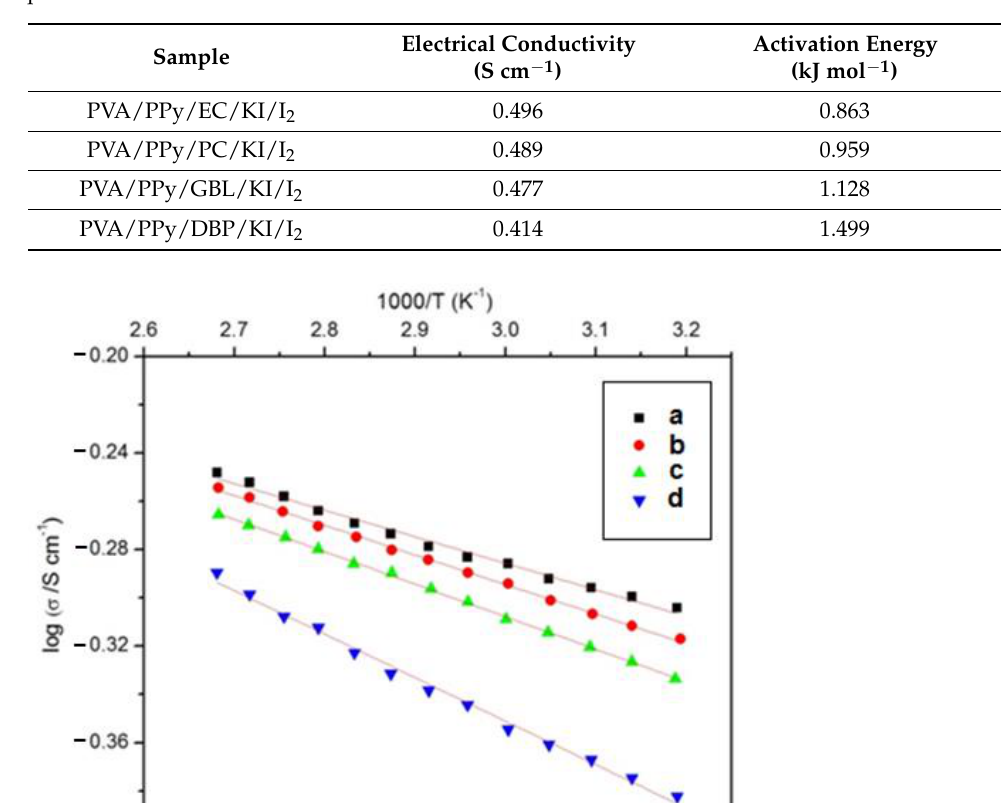
Figure 5. Electrical conductivity–temperature plots of the PVA/PPy/KI/I 2 electrolyte with various plasticizers (in wt.%); ( a ) EC, ( b ) PC, ( c ) GBL, and ( d ) DBP. Table 3. Electrical conductivity and activation energy of the PVA/PPy/KI/I 2 electrolyte with different plasticizers.